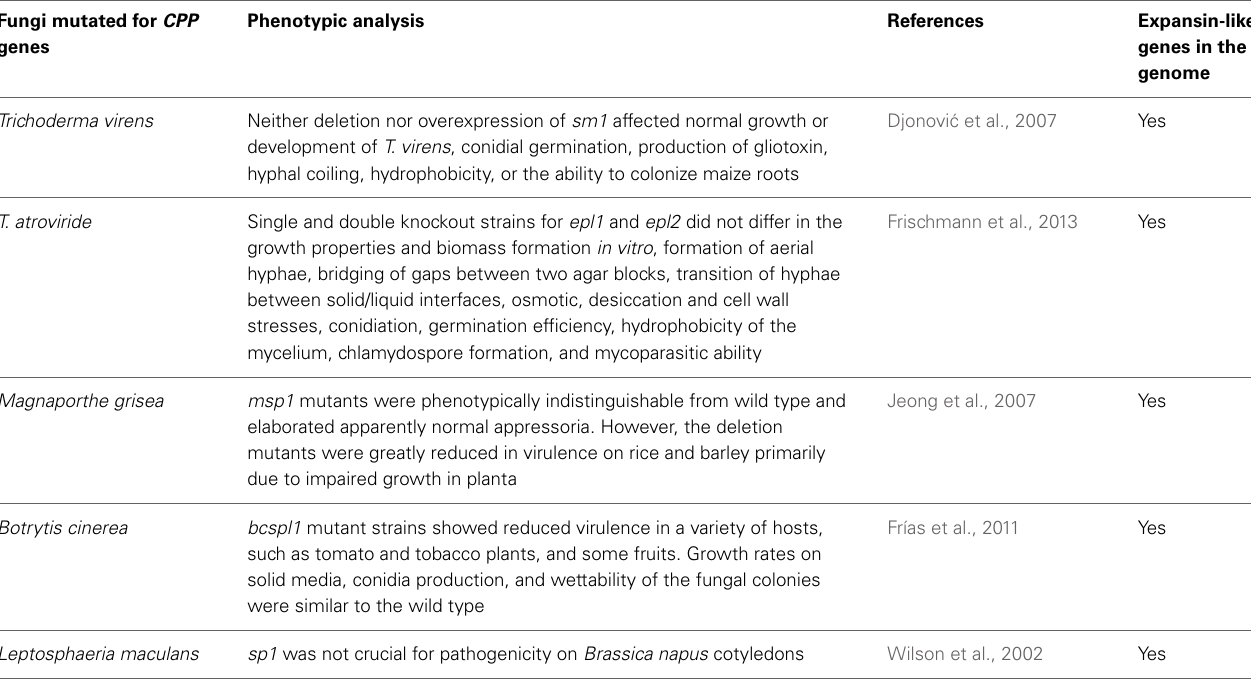
Table 1 | Summary table of the mutants obtained up to date for genes encoding cerato-platanin family proteins (CPPs). Fungi mutated for